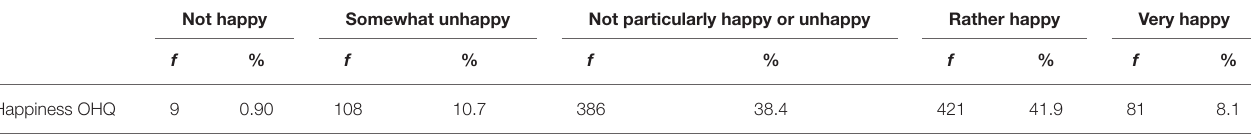
TABLE 3 | Happiness total score categorization ( N = 1,005). Not happy Somewhat unhappy Not particularly happy or unhappy Rather happy Very happy